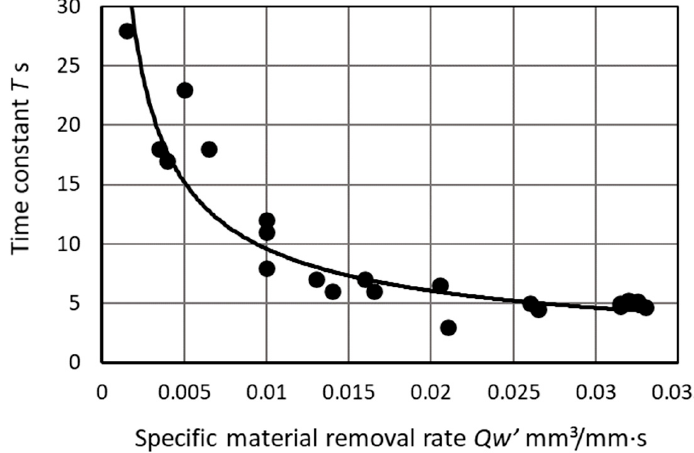
Figure 23. The effect of specific material removal rate on the time constant in plunge centerless grinding.